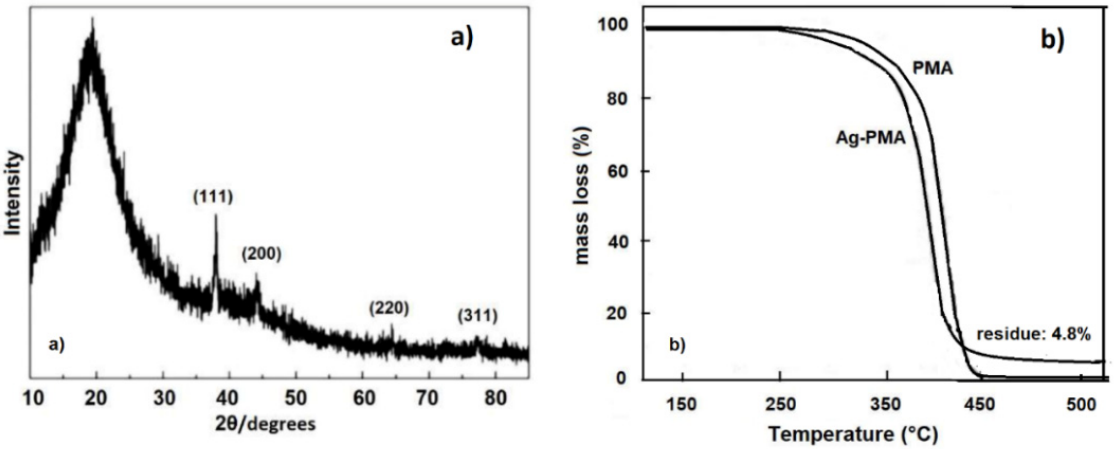
Figure 3. STEM images ( a , b ) of Ag-PMA nanocolloid (before and after one month of storage) and the corresponding size distribution histogram obtained by using Matlab Toolbox for image analysis ( c ). Zeta potential values of Ag-PMA colloidal solution at different conditions ( d ) are reported.